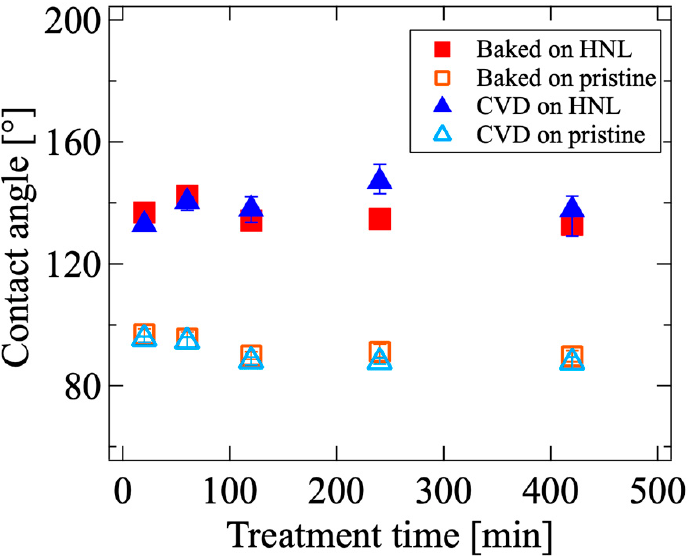
Figure 1. Water-contact angles on PDMS-coated HNL and pristine glass. HNL-based samples exhibited higher hydrophobicity for both baking and CVD methods.